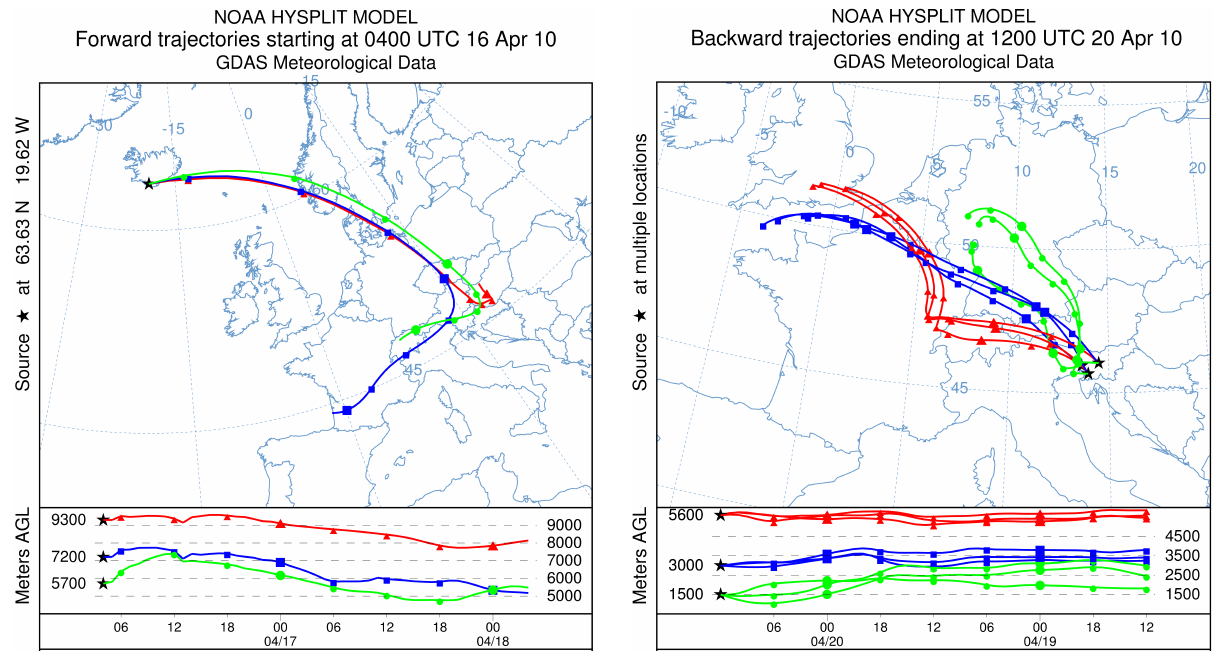
Fig. 13. Air flow trajectories for a 48-h time interval with 6-h temporal resolution obtained from the HYSPLIT model. Left: forward trajectories for air masses originating near the Eyjafjallajökull volcano starting on 16 April 2010 at 04:00UTC; Right: backward trajectories of air masses reaching Ljubljana, Divaˇca and Nova Gorica on 20 April 2010 at 12:00UTC.